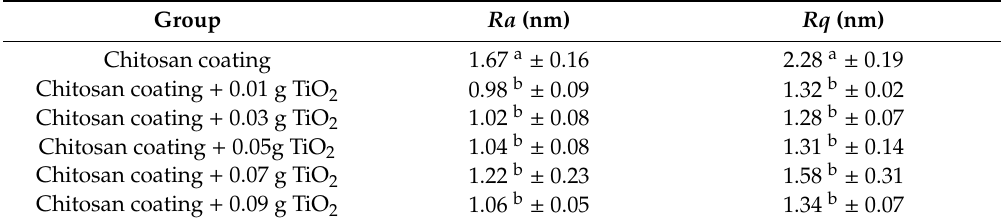
Table 1. E ff ects of TiO 2 concentration on the arithmetic average roughness ( Ra ) and the root mean square roughness ( Rq ) of chitosan coating films